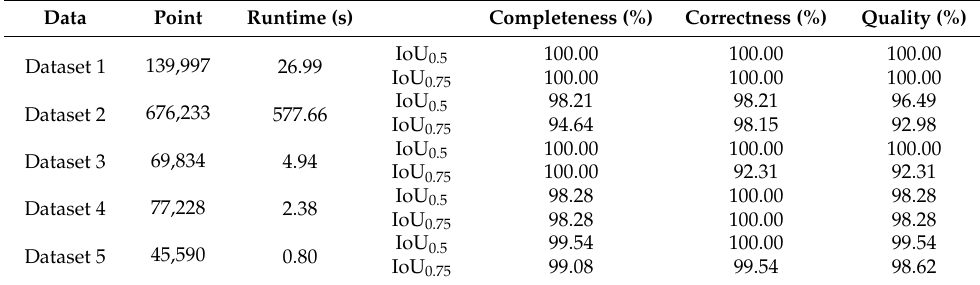
Table 2. Quantitative evaluation of building instance segmentation